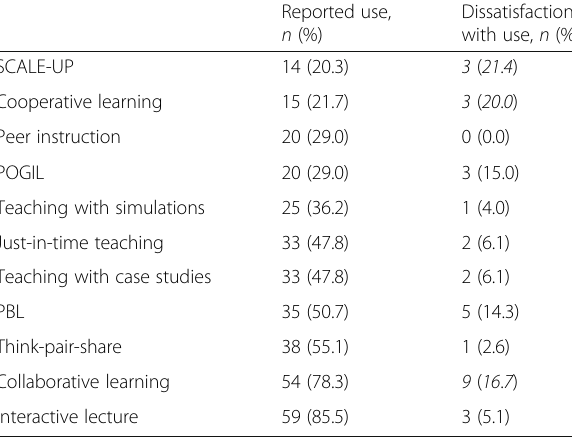
Table 7 Participant use and dissatisfaction with EBIPs